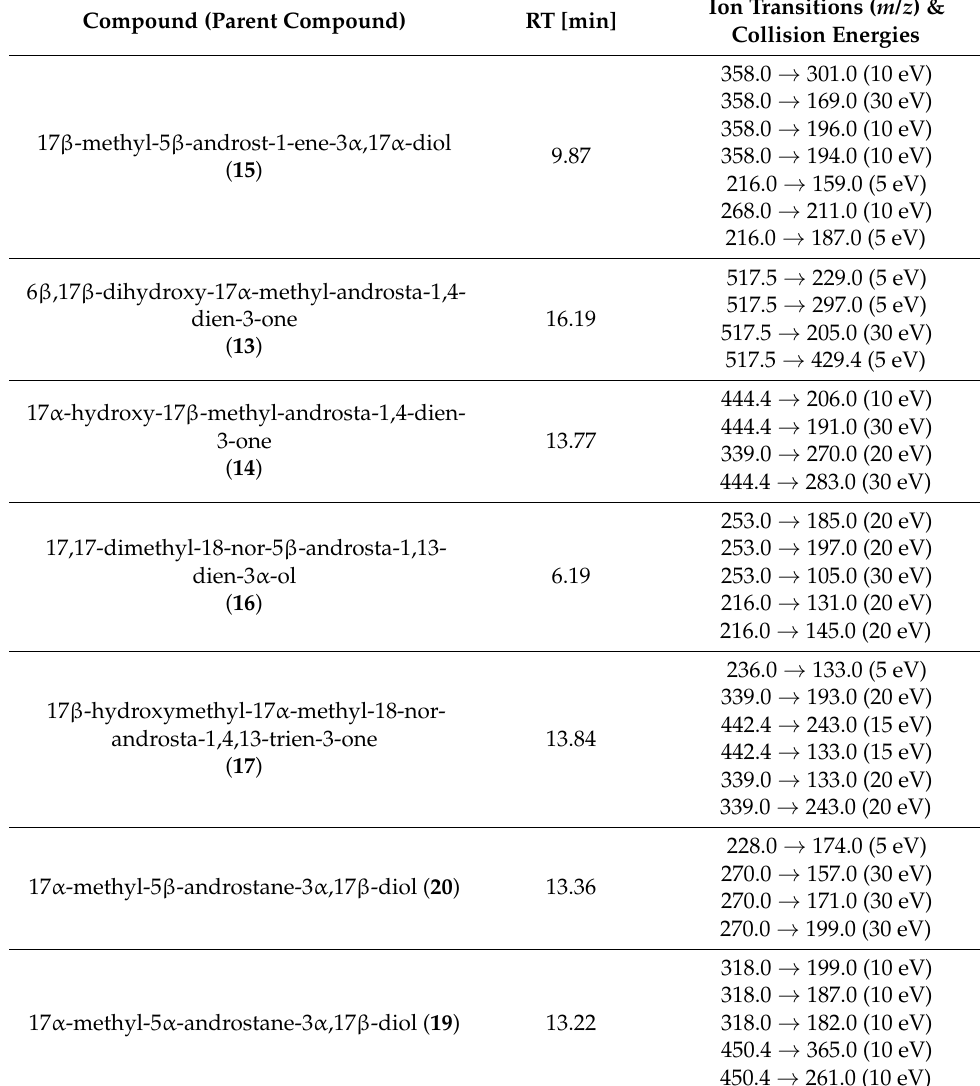
Table 3. Retention times (GC-QQQ-MS) and ion transitions of currently targeted metabolites in anti-doping